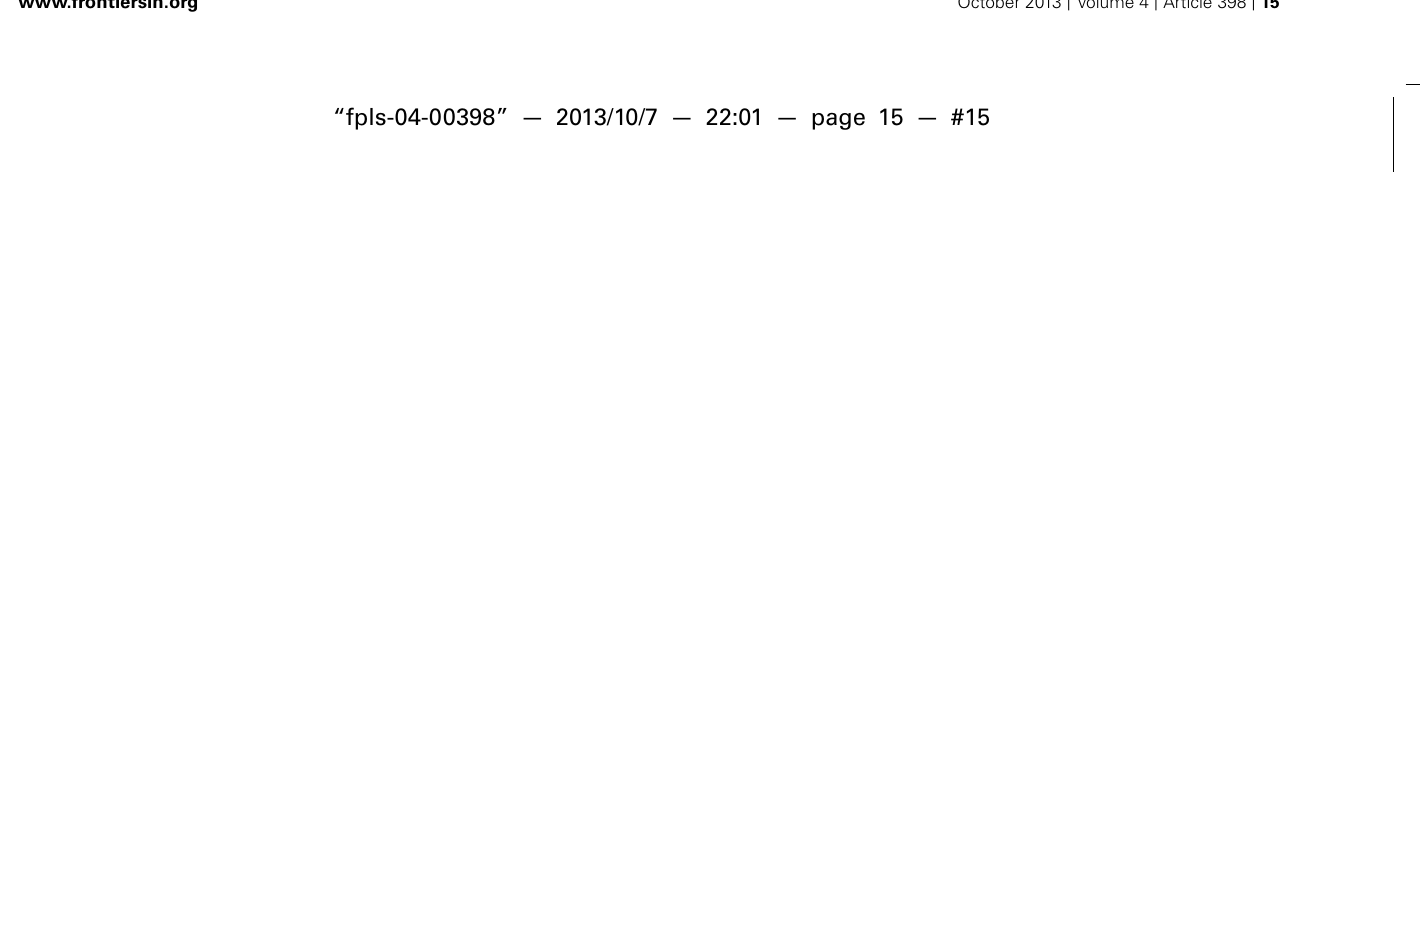
where this protein binds TGA-class transcription factors, which subsequently activate promoters of SA-responsive genes. (5) NO also stimulates JA biosynthesis. (6) Cytosolic, oligomeric NPR1 represses JA-triggered responses. (7) At late stages of bacterial infection, S -nitrosylation of SA-binding protein 3 (SABP3) at cys280 represses its SA binding capacity, thereby promoting a negative feedback loop during the defense signaling pathway. Protein S -nitrosylation is represented by